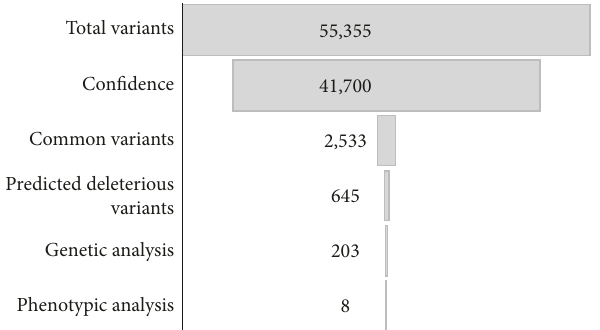
Figure 1: Ingenuity Variant Analysis (IVA) filtering schematic to determine genes of interest in the patient. Genes were filtered based upon confidence that the sequence was correctly sequenced, how common the gene is in the wider gene pool, a prediction of the variants’ deleterious effect, and then the type of genetic mutation that it is. Genecards.org was then used to determine the phenotypic relevance of the gene to the symptoms of our